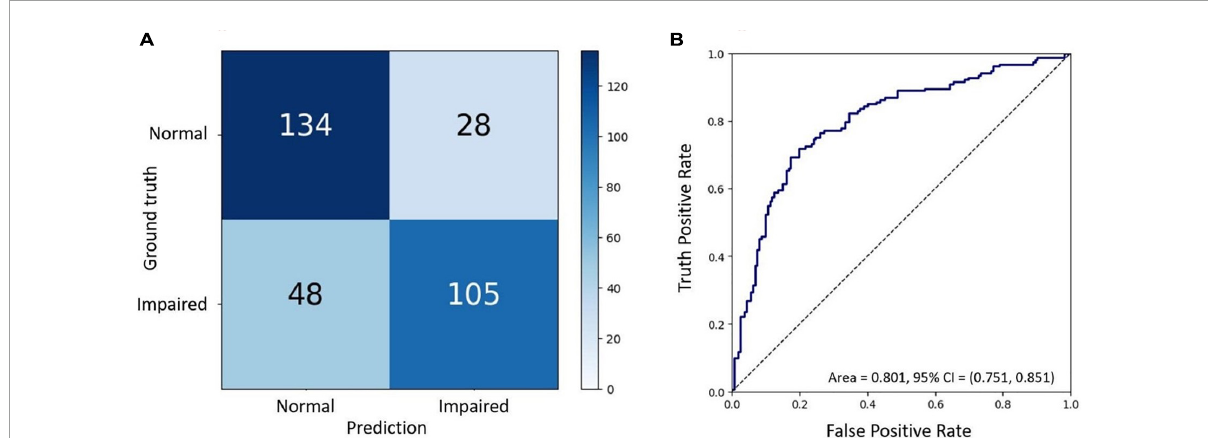
FIGURE5 The final test of the trained AI model. (A) Confusion matrix demonstrating the accuracy of prediction of two visual acuity classes based on the validation dataset of OCT images. (B) Receiver operating characteristic (ROC) curve showing the accuracy of prediction with the area under the curve (AUC) = 0.801.